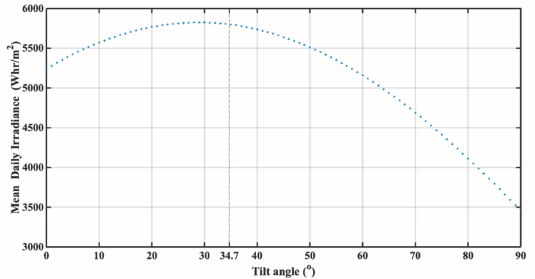
Figure 13. Daily average solar energy reaching a tilted surface with respect to tilt angle. Red vertical line corresponds to the latitude of